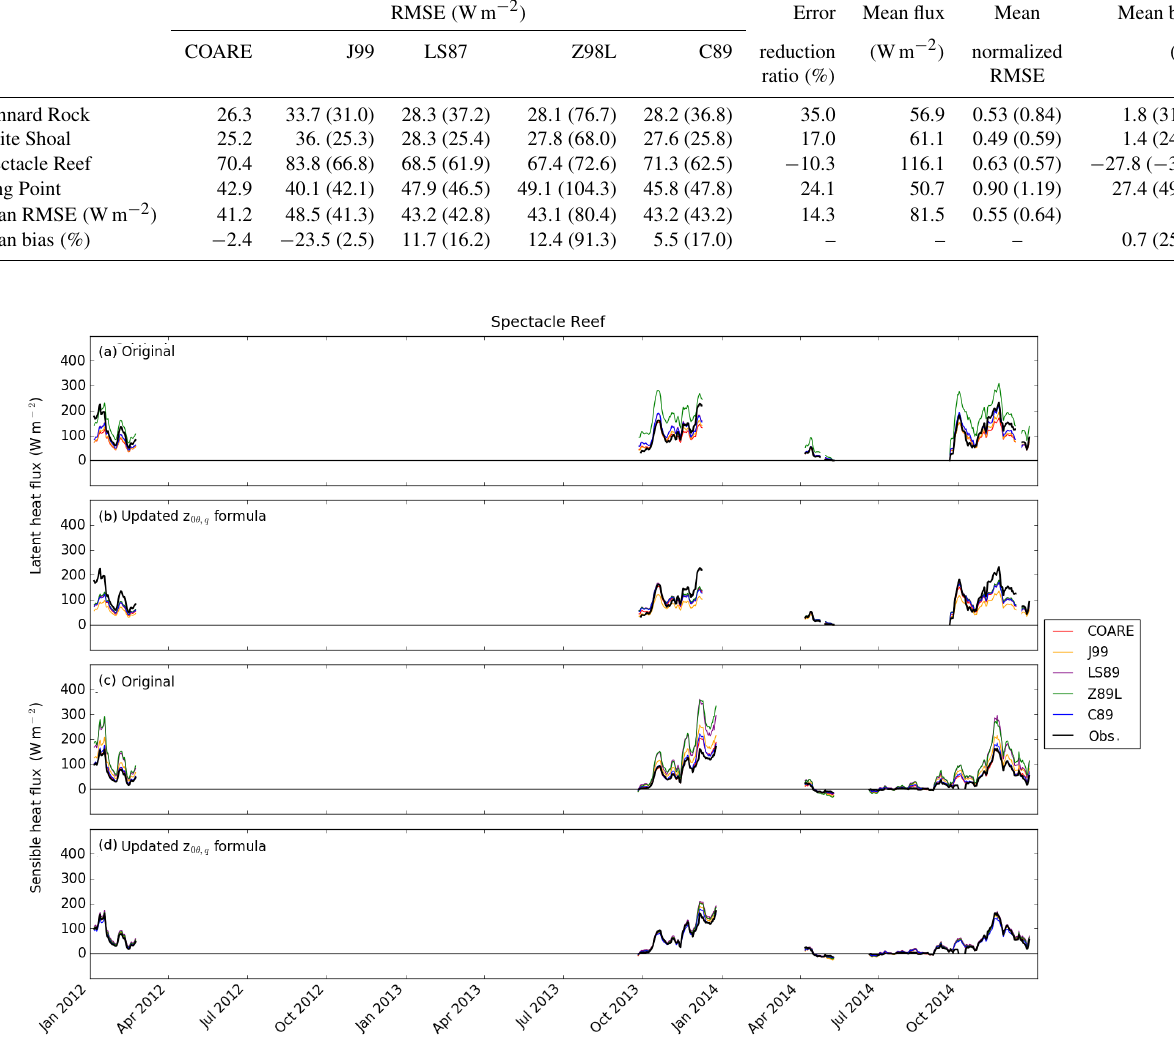
Figure 6. The same as Fig. 4, but at Spectacle